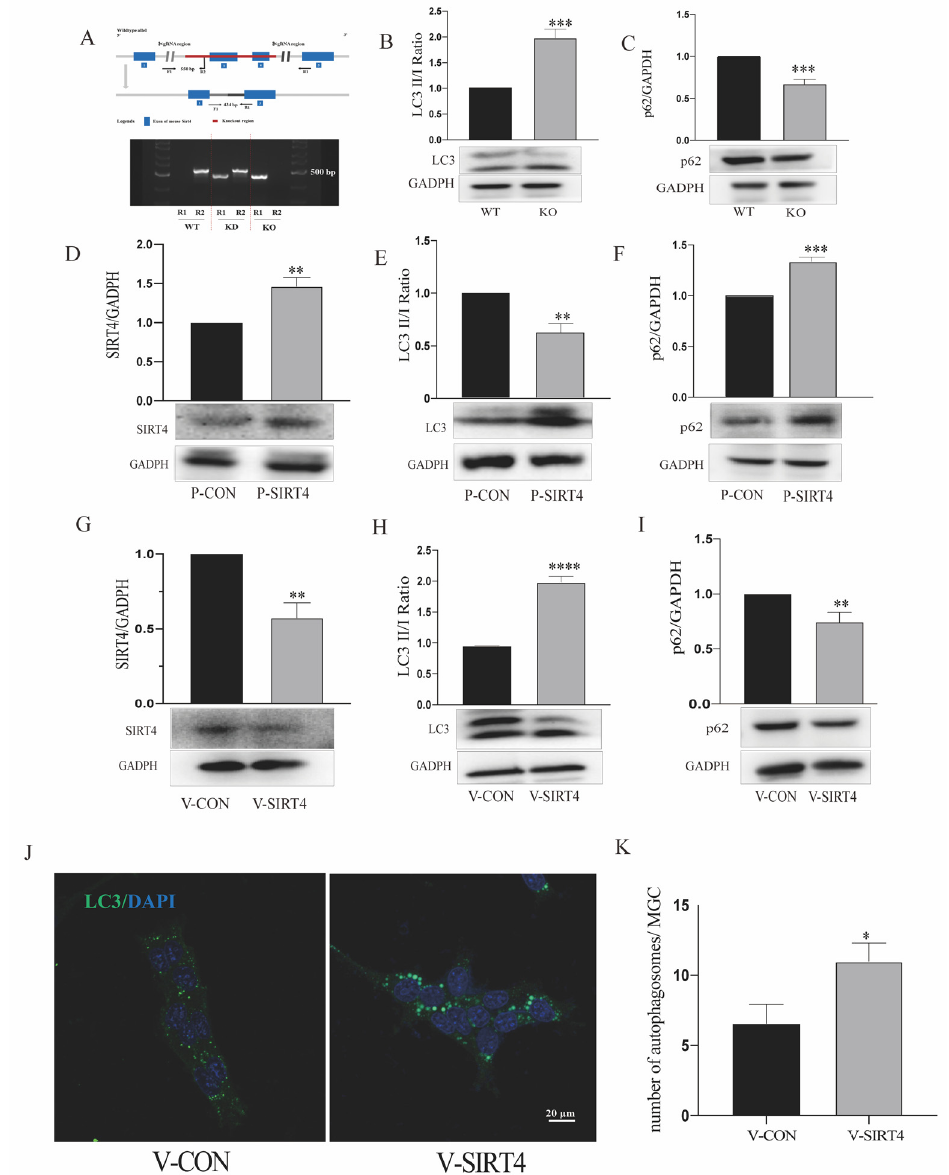
Figure 6. SIRT4 can modulate autophagic function in vivo and in vitro. ( A ) Genotyping identification of SIRT4-knockout mice. ( B , C ) Autophagic flux in retinas of wild-type and SIRT4-knockout mice was monitored by LC3-II/I conversion with anti-LC3 and SQSTM1/p62 antibodies. ( D ) The overexpression efficiency of the SIRT4 plasmid was validated by western blotting. ( E , F ) Autophagic flux in P-CON and P-SIRT4 r-MCs was monitored by LC3-II/I conversion with anti-LC3 and SQSTM1/p62 antibodies. Data are shown as means ± SEMs. ( G ) The knockout efficiency of the SIRT4 lentivirus was validated by western blotting. ( H , I ) Autophagic flux in V-CON and V-SIRT4 r-MCs was monitored by LC3-II/I conversion with anti-LC3 and SQSTM1/p62 antibodies. Data are shown as means ± SEMs. ( J ) Autophagic puncta in MGCs were obtained by immunostaining with an LC3 antibody (scale bar: 20 μ m). ( K ) Quantitative analysis of autophagic puncta in MGCs. Data are shown as means ± SEMs. ( n = 3 per group; * p < 0.05, ** p < 0.01, *** p < 0.001, and **** p < 0.0001). SIRT4, sirtuin 4; WT, wild type; KO, knockout; p62, SQSTM1/p62.